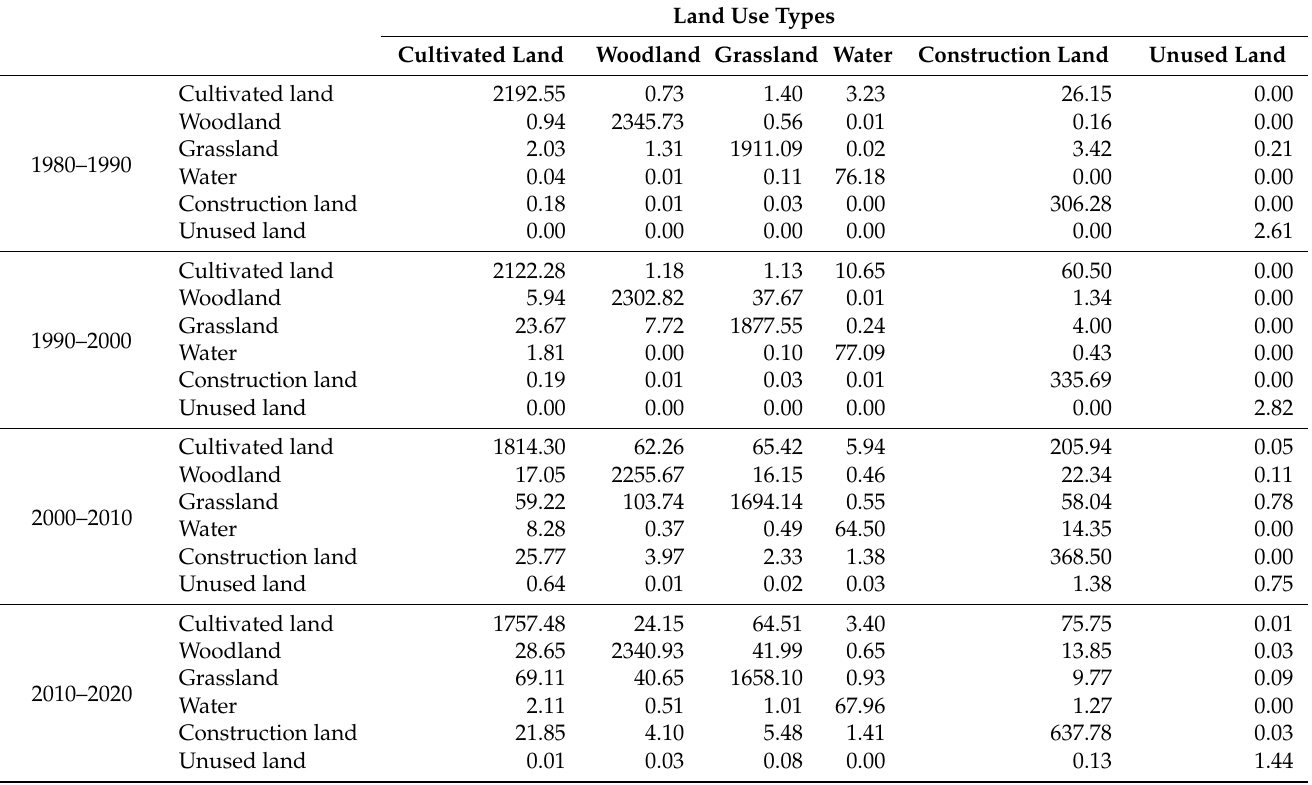
Table 2. Land use transfer matrix of Taiyuan City from 1980 to